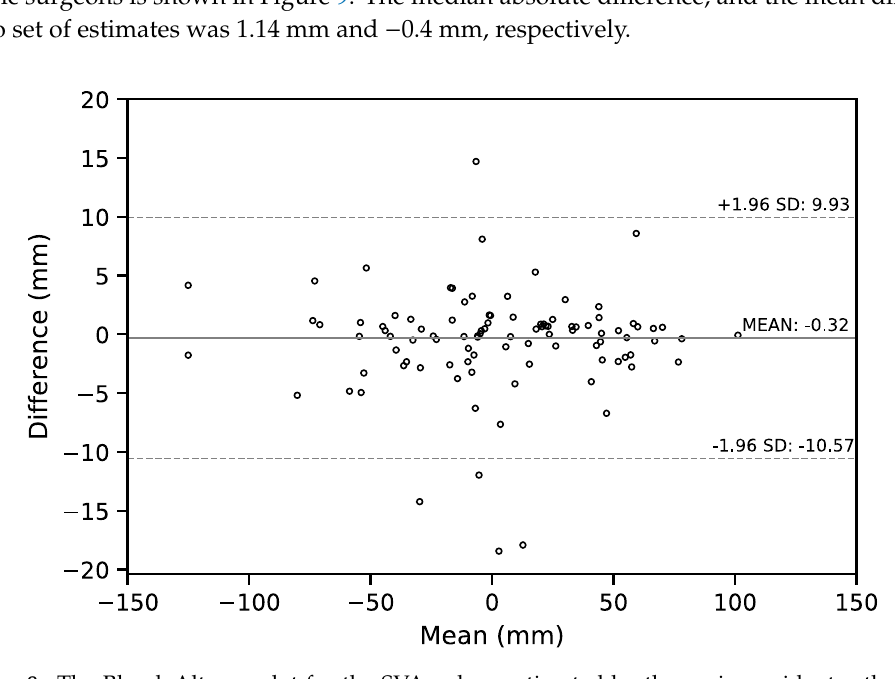
Figure 8. The Bland–Altman plot for the SVA values estimated by the senior resident orthopedic surgeon and the ResUNet model. The horizontal lines of mean difference (solid line) and mean difference ±1.96 standard deviation (SD) are plotted (dashed lines).